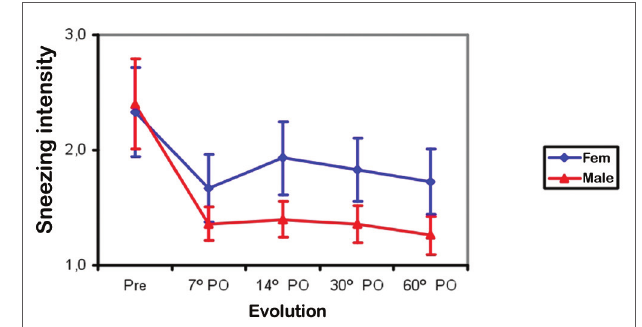
Figure 6. Mean coughing bout score in males (Male) and females (Fem) in the preoperative (Pre) and postoperative (PO) periods. 7 th and 60 th postoperative days (Figure 6).